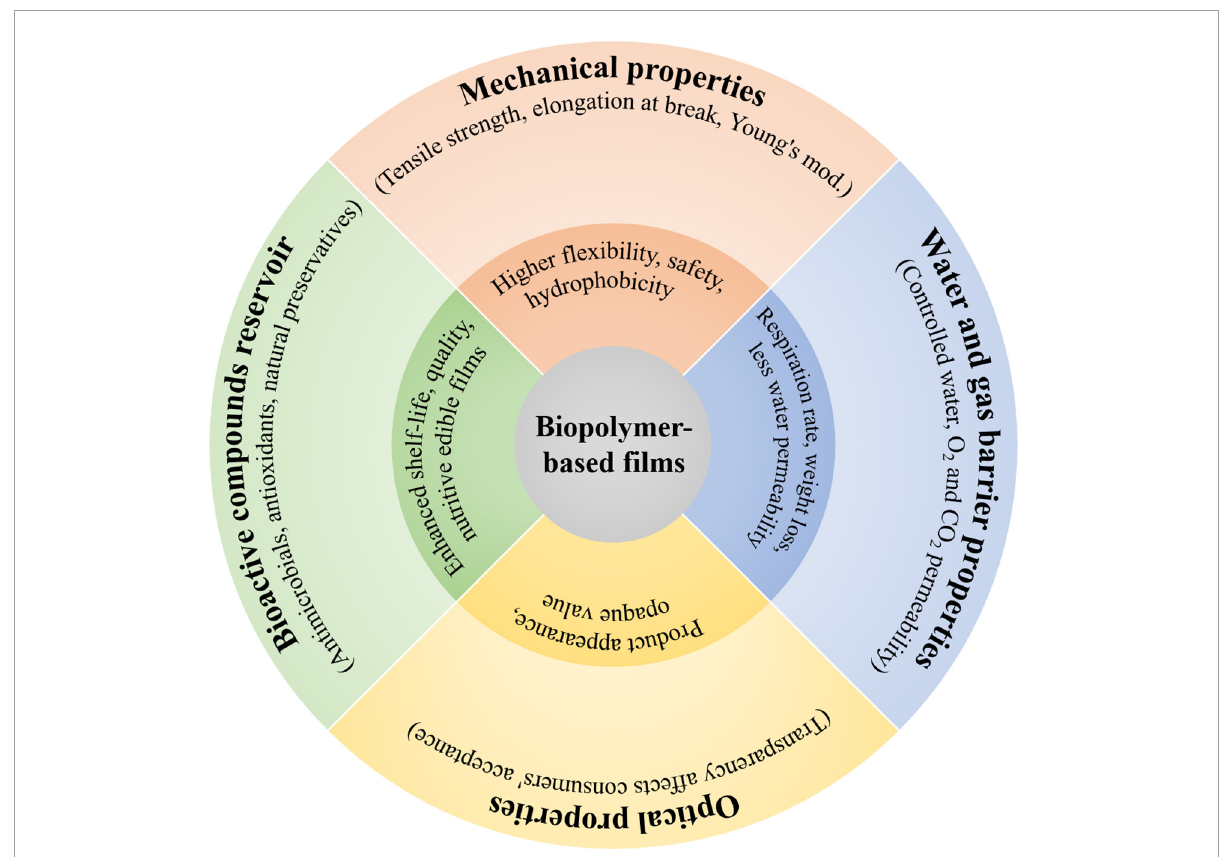
FIGURE4 Special functions induced by biopolymers to the film matrix, including mechanical-, water and gas barrier-, and optical properties as well as bioactive compounds reservoir.